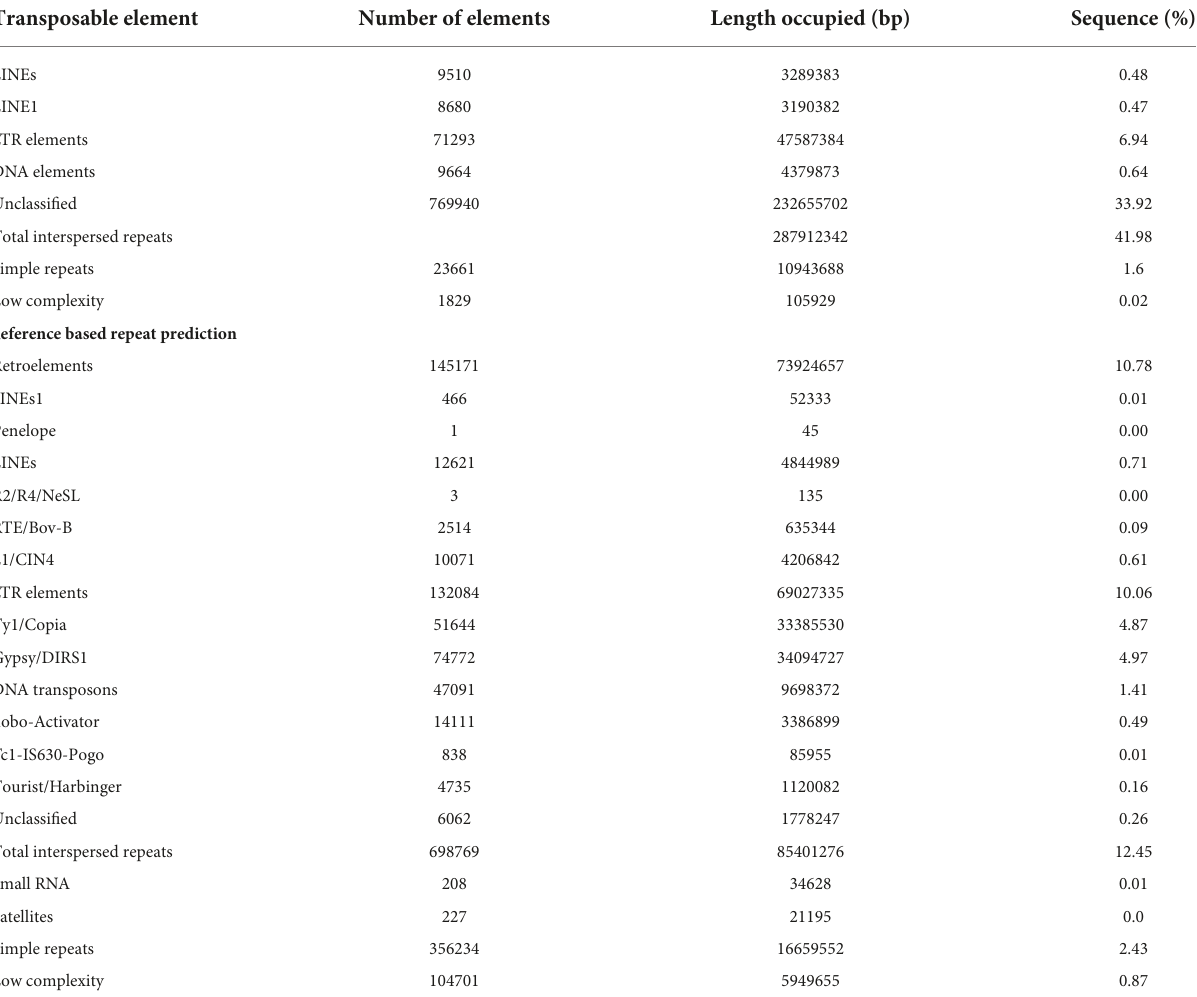
TABLE 4 De novo and reference-based prediction of repetitive sequences in the pongamia